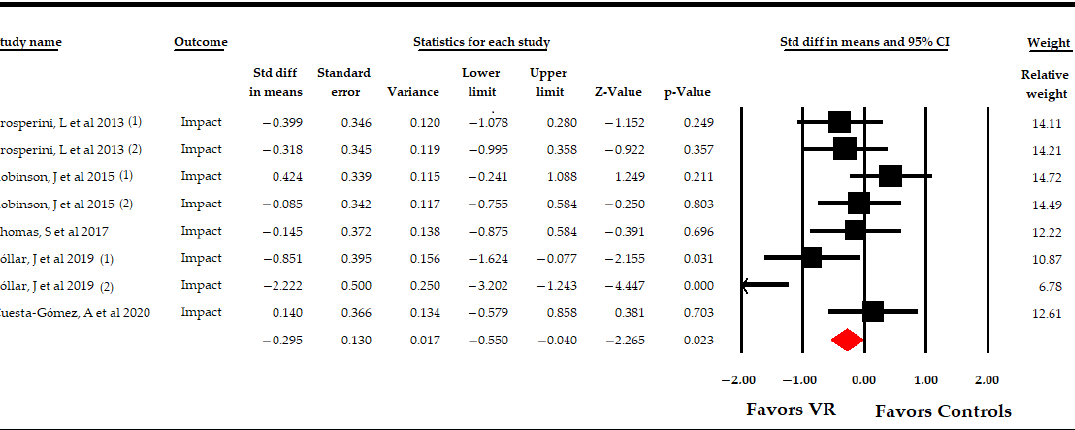
Figure 4. Forest Plot of the Effect of Virtual Reality on the Impact of Multiple Sclerosis.